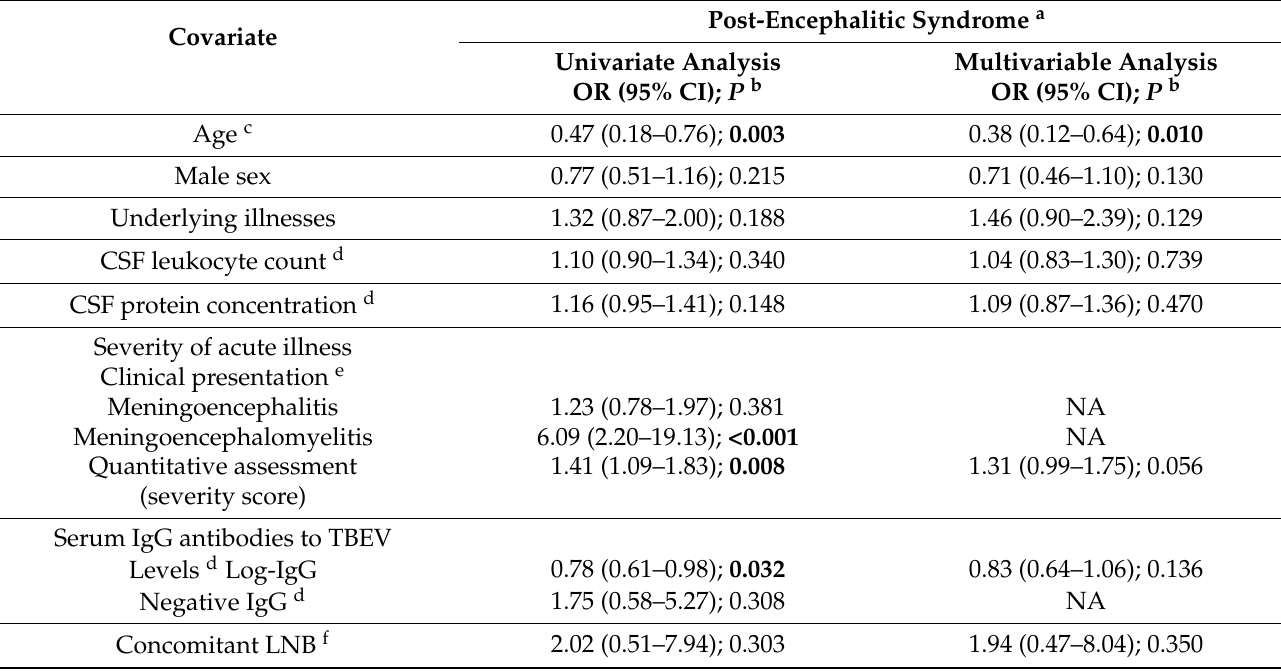
Table 4. Association of covariates representing acute illness with the post-encephalitic